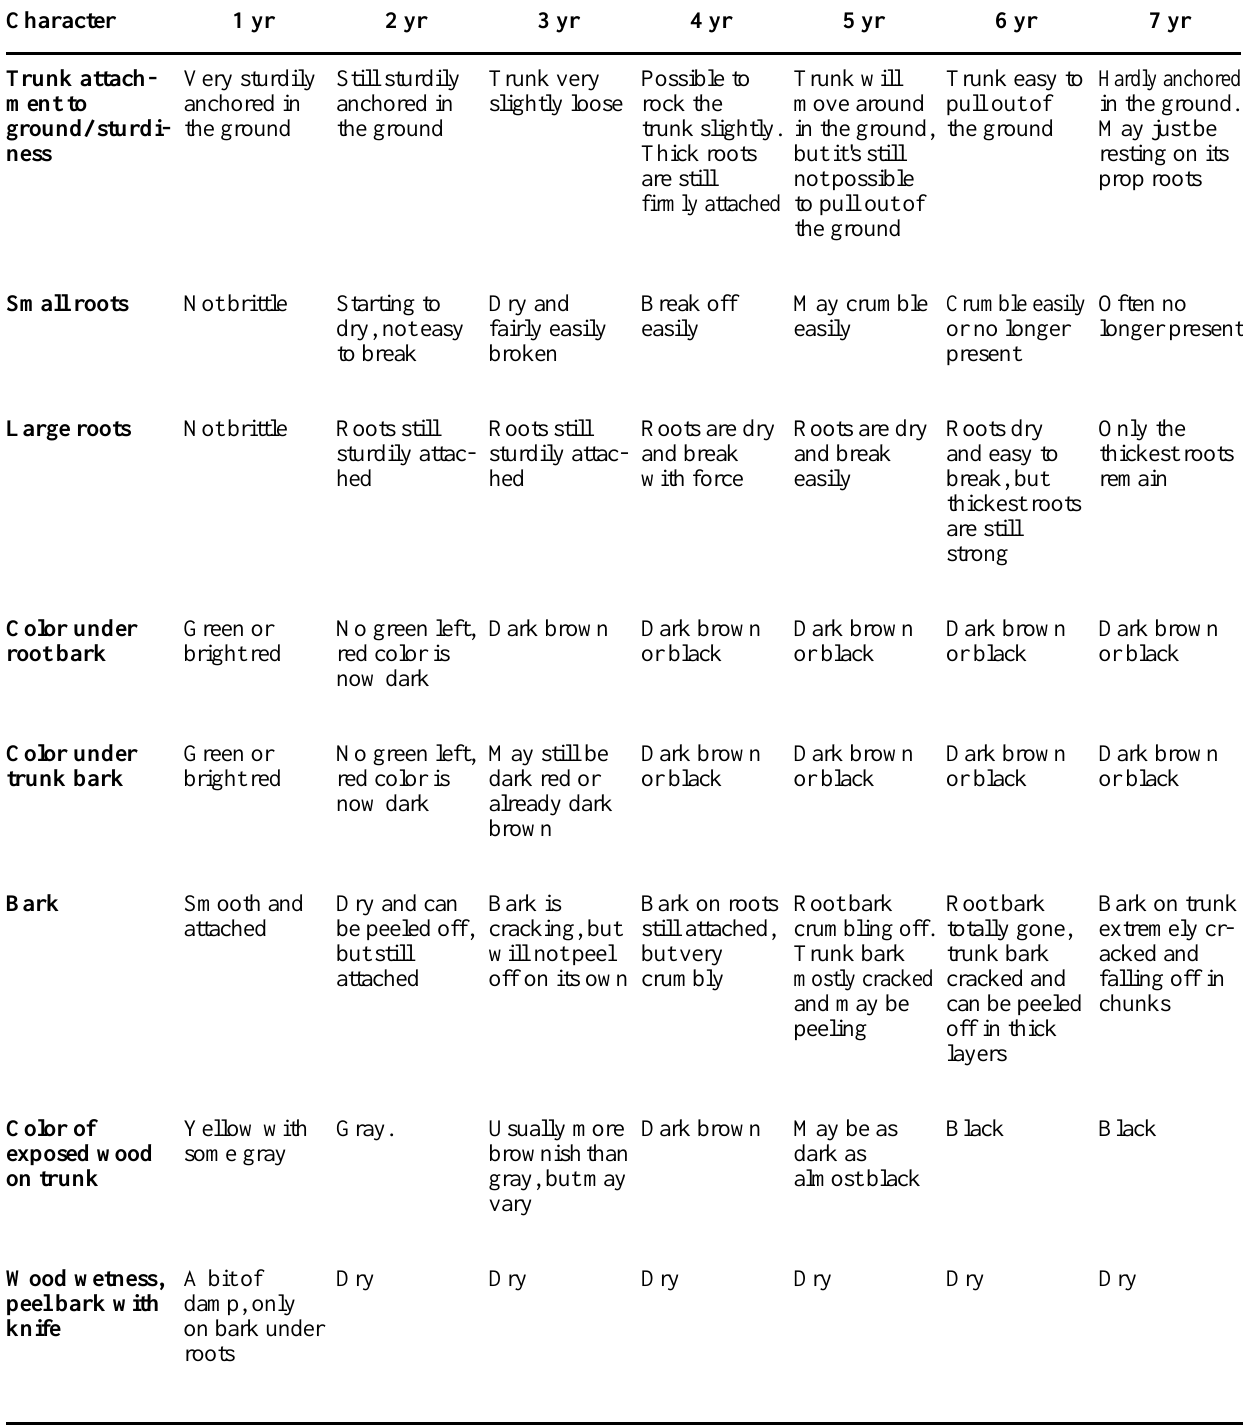
Table 2. Criteria used to estimate the length of time since a stump was